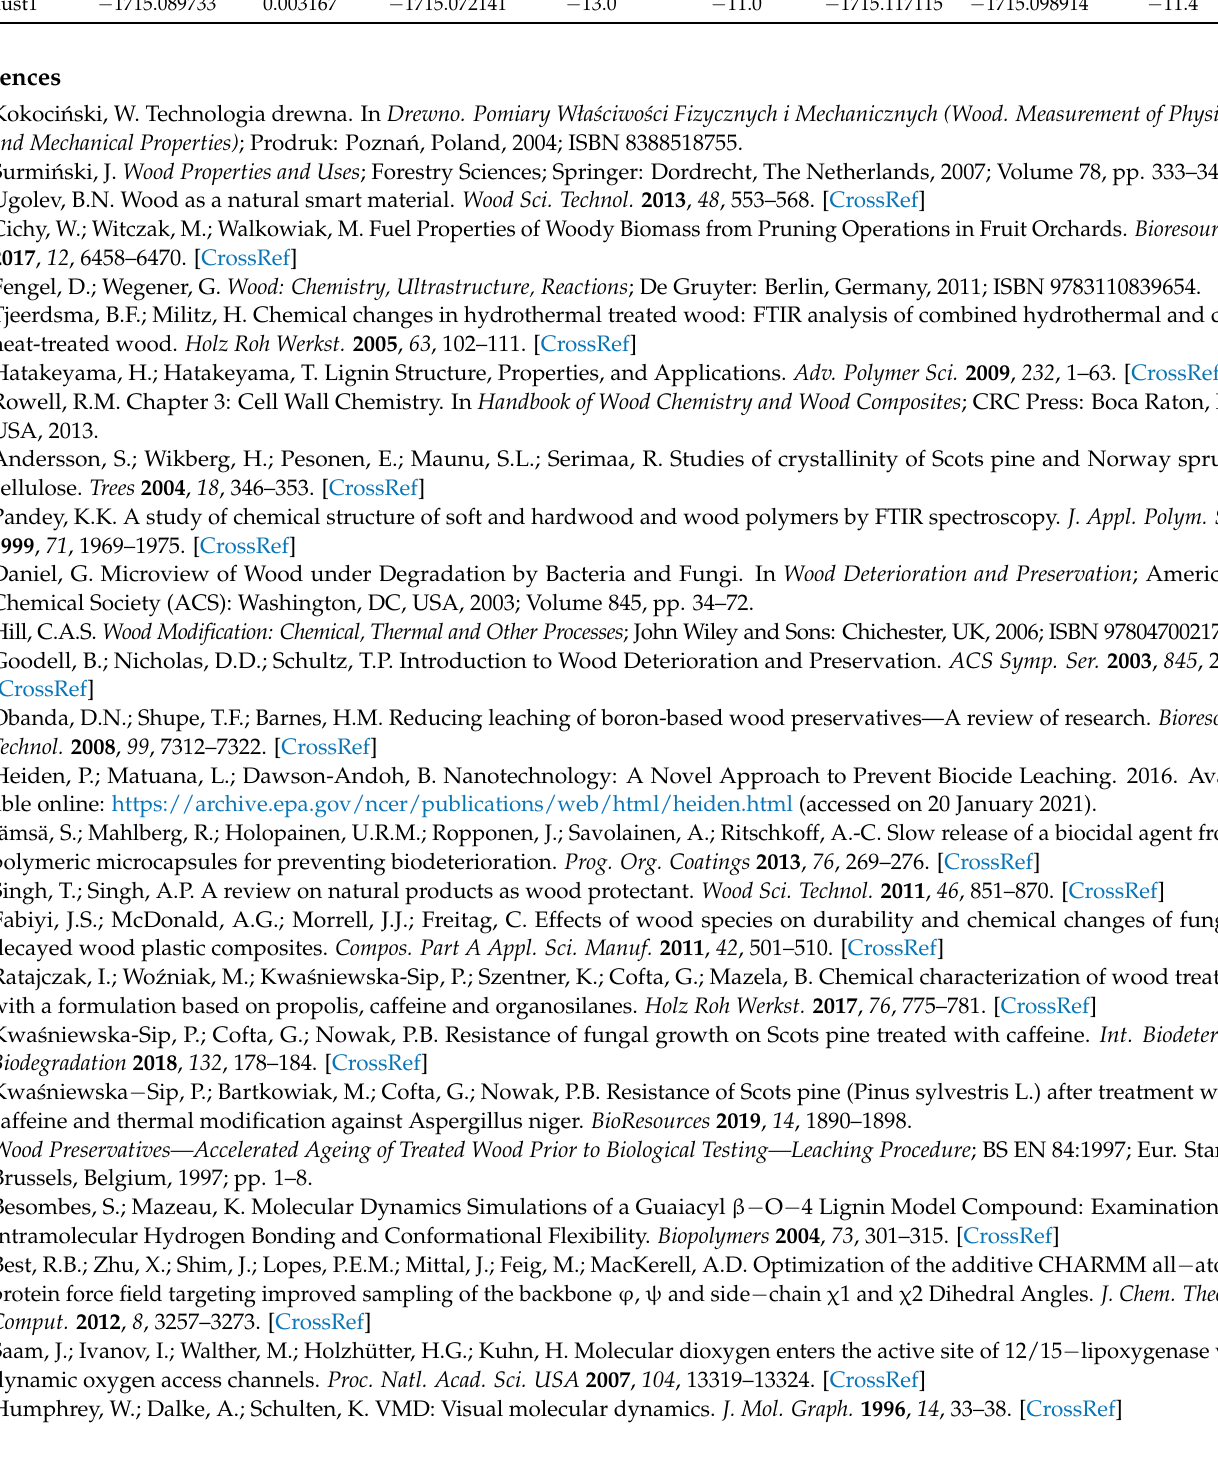
Table A3. Extended version of Table 3 with calculated energies (counterpoise energy, BSSE, sum of the energy of monomers, counterpoise uncorrected, corrected interaction energies in a vacuum, sum of the energy of monomers and interaction energy in water) for the studied system consisting of α R, β R guiacyl β -O-4, and caffeine. System Consisted of α R, β R Guiacyl β -O-4 and